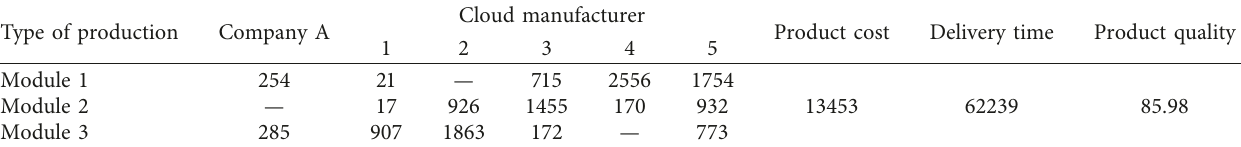
Table 8: Final optimum production planning